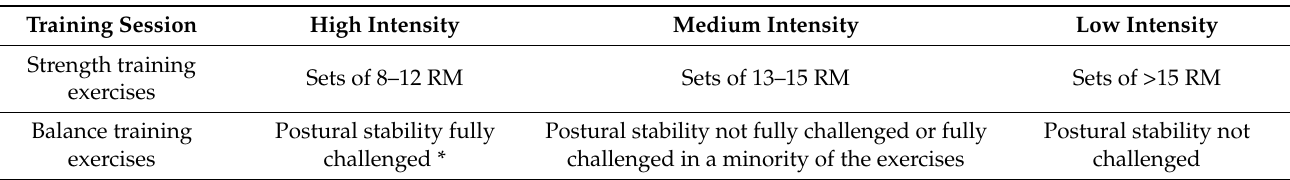
Table 2. Intensity scales for HIFE